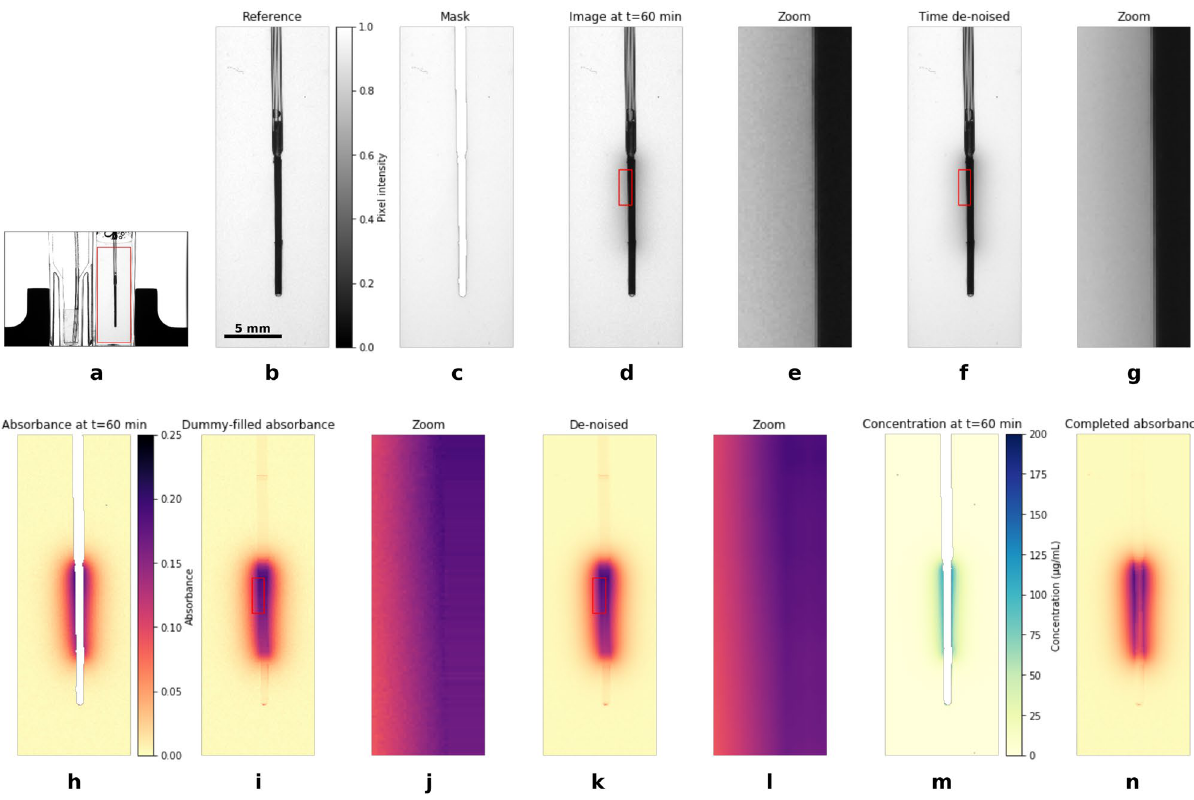
Figure 4. Illustration of the image processing workflow; ( a ) Full view; ( b ) Selected region; ( c ) Mask; ( d ) and 60 min; ( f ) and ( g ) Image at time t 60 min after time denoising; ( h ) Absorbance; ( i ) and ( e ) Image at time t = = ( j ) Dummy filled absorbance; ( k ) and ( l ) Absorbance after spatial denoising; ( m ) Reconstructed concentration field; ( n ) Completed absorbance.